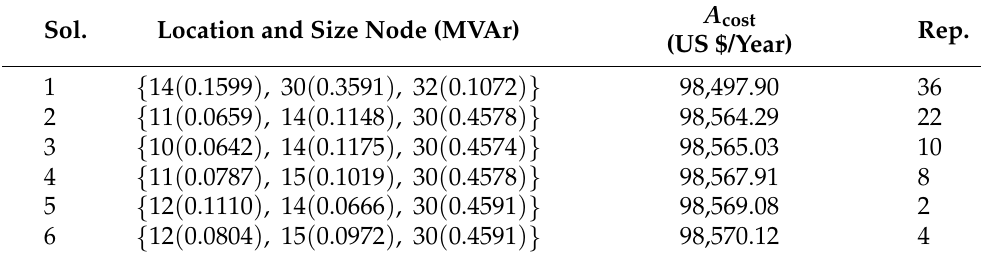
Table 8. Lists of solutions found by the proposed DCVSA in the IEEE